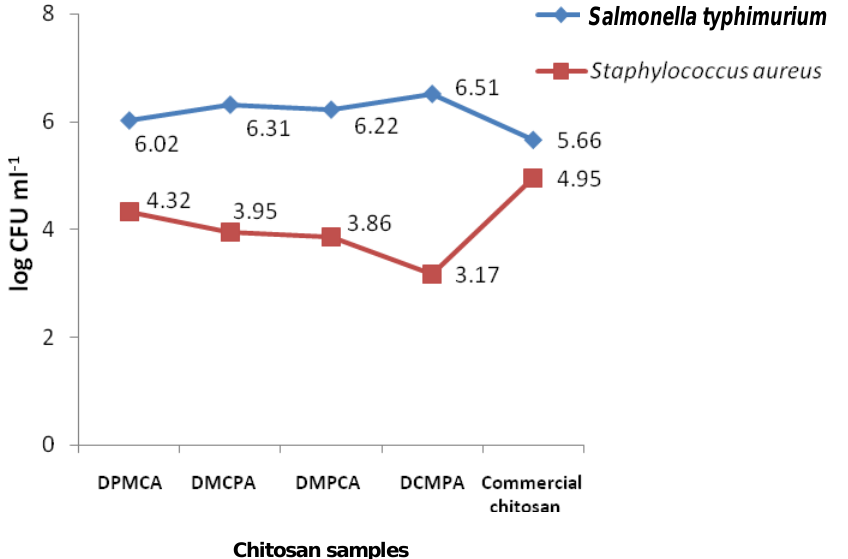
Figure 2. Antibacterial activity of four Artemia and commercial chitosan samples [0.1%